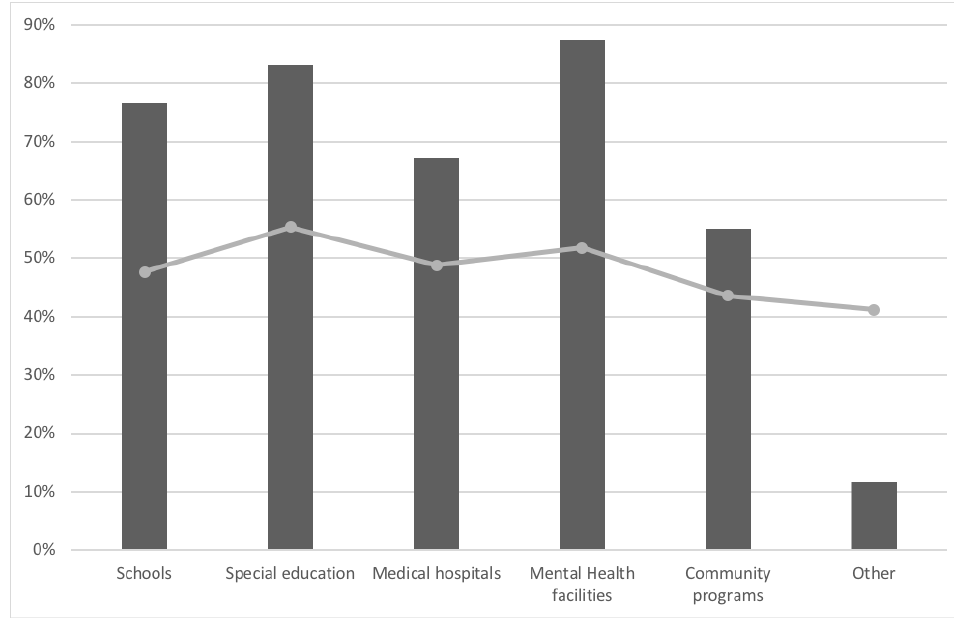
Comparison of work settings of music therapists and other professionals (Block = other professionals